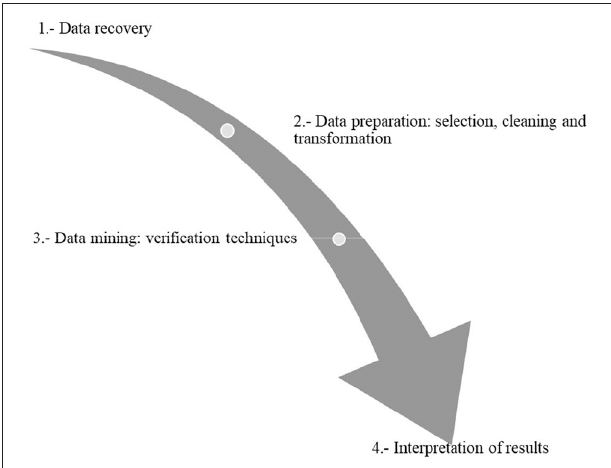
FIGURE 1 | Phases of the KDD process. Source: Own elaboration based on Flores et al. (2019).